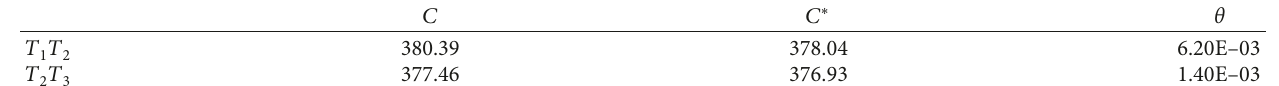
Table 10: Comparison of carbon penalty rates in cross-period time-varying network.